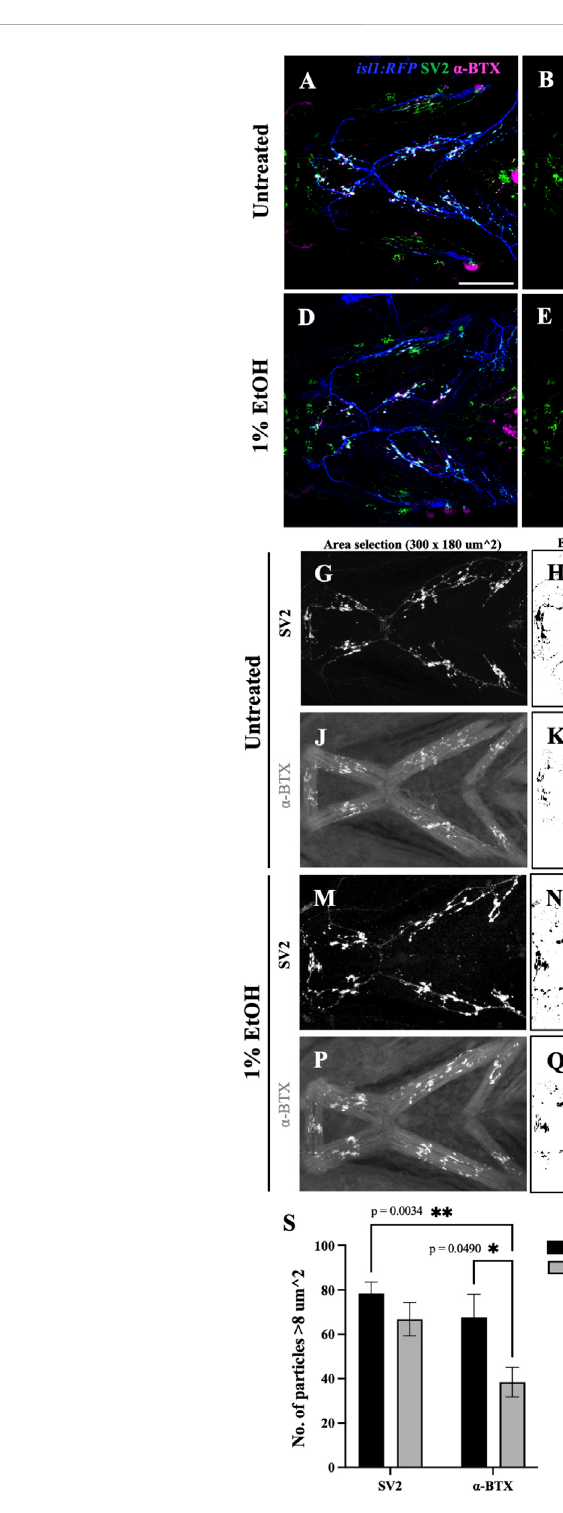
FIGURE 11 Number of postsynaptic receptors are reduced in ethanol-exposed fi sh (A – F) Immunostained neuromuscular junctions (NMJs) composed of presynapticterminals(labeledwithSV2)andpostsynapticacetylcholinereceptors(labeledwith α -BTX)inuntreated (A – C) andethanol-exposed (D – F) isl1:RFP fi sh. A and D are merged images with motor neurons (in blue), SV2 (in green) and α -BTX (in magenta). (G – R) Quanti fi cation of presynaptic and postsynaptic terminals in untreated (G – L) and ethanol-exposed (M – R) fi sh. NMJs were counted for Intermandibularis anterior, Intermandibularis posterior and Interhyalmusclesbyselectinganareaof300x180 um ^ 2asshowninG,J,MandP.H,K,NandQshowtotalnumberofparticlesaftersegmentation.I,L,OandR show particles with sizes greater than 8-micron square. (S) Number of α -BTX labeled particles > 8 um ^ 2 signi fi cantly reduced in ethanol-exposed fi sh. There was no signi fi cant change in the number of SV2 labeled particles. * = p < 0.05; ** = p < 0.01. Scale bar = 100